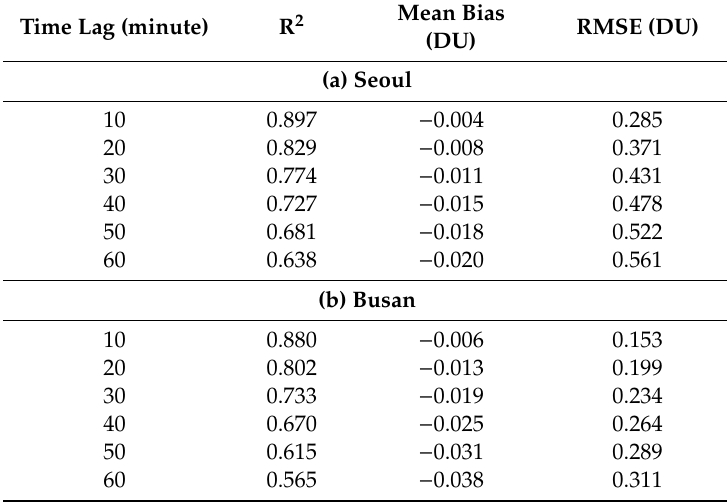
Table 4. Statistical results for temporal variability of total column amount of NO 2 (TCN) with time lag change in ( a ) Seoul and ( b )